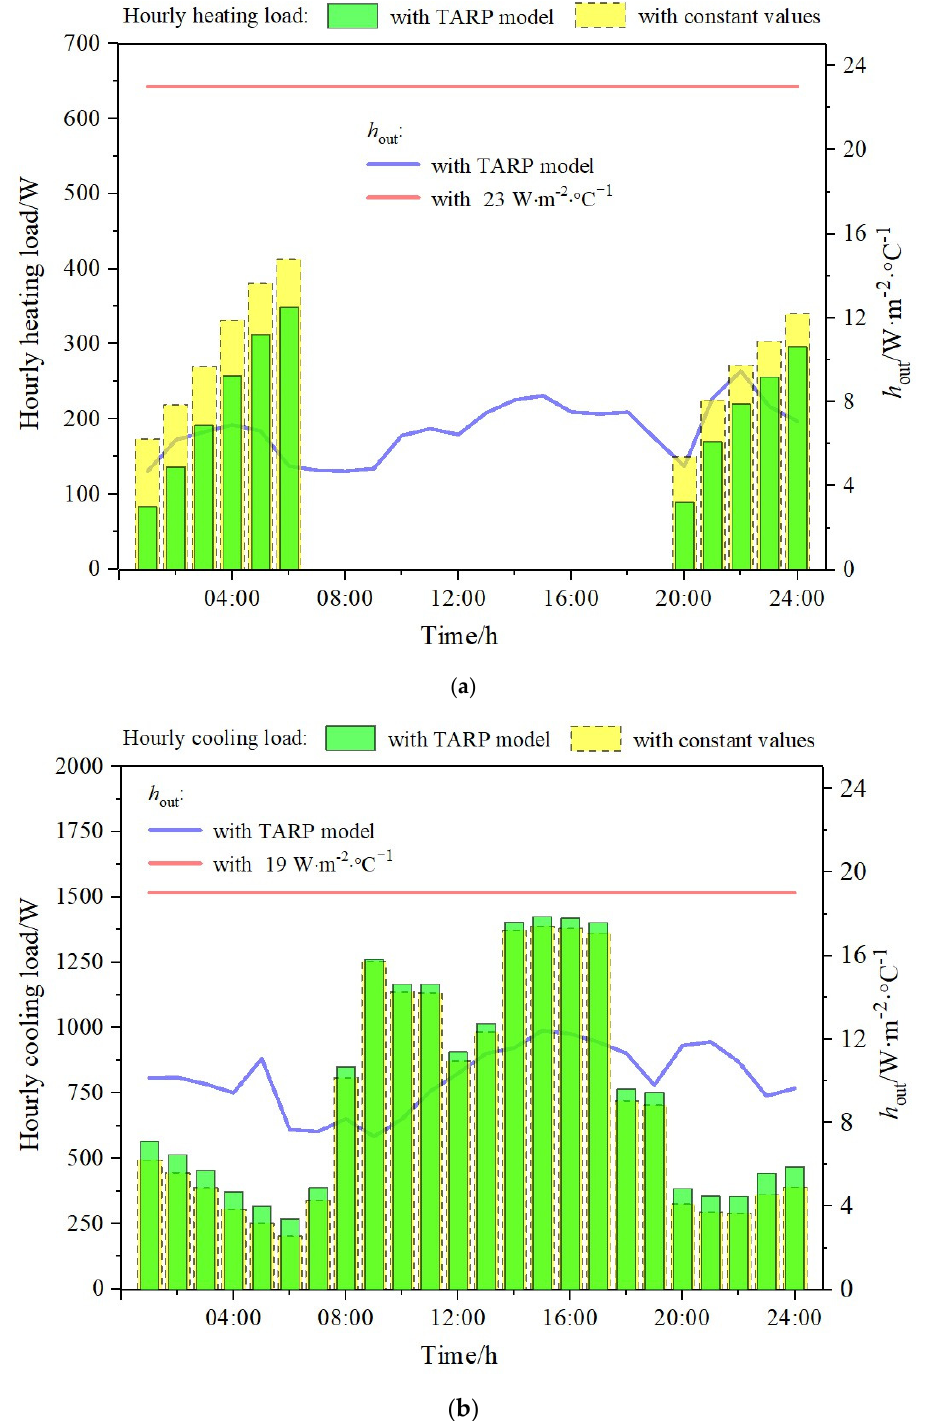
Figure 7. Comparisons of hourly loads with different external SHTCs on a typical day: ( a ) Hourly heating load on a typical day in winter; ( b ) Hourly cooling load on a typical day in summer.